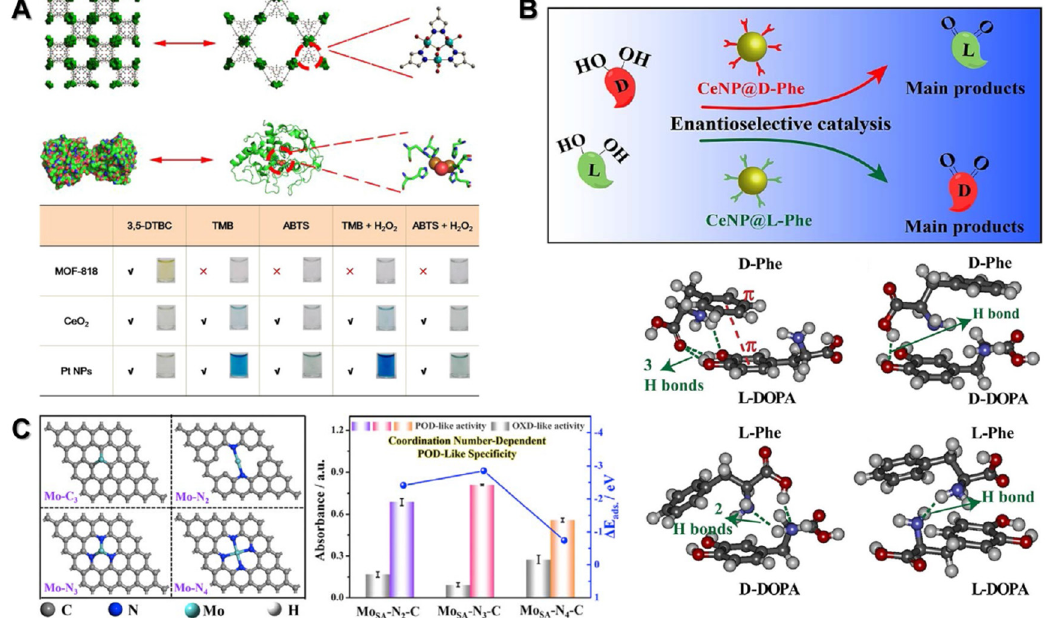
Figure 4. ( A ) Catechol oxidase-inspired design of MOF-818 showing a high catalytic